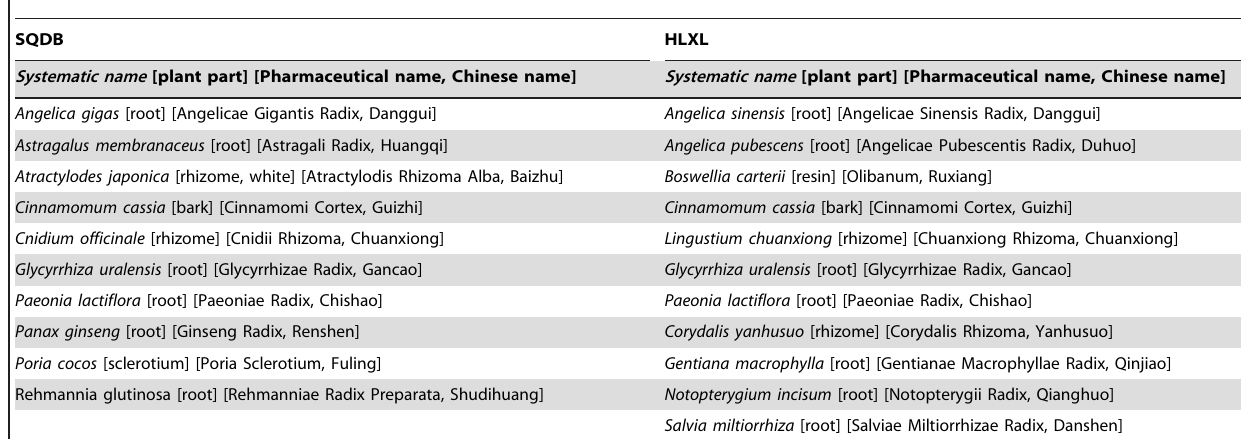
Table 1. Botanical names and origin of the formulas SQDB and HLXL.